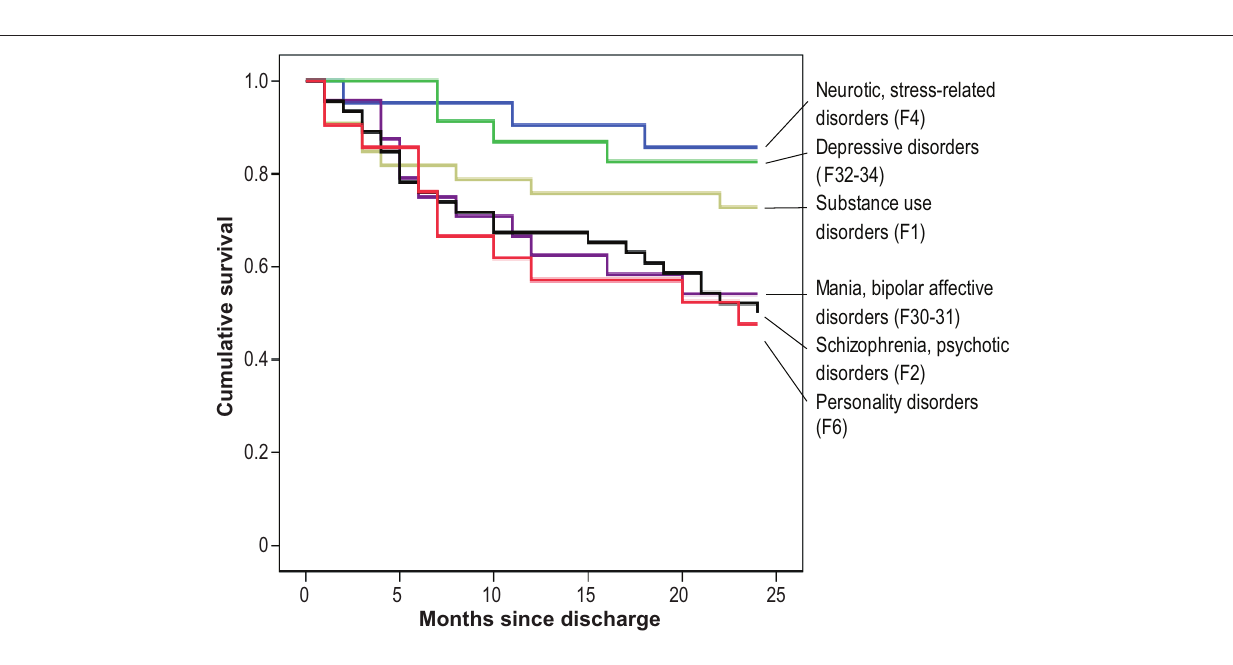
FIGURE 2 | Cumulative risk of compulsory re-admission, by psychiatric